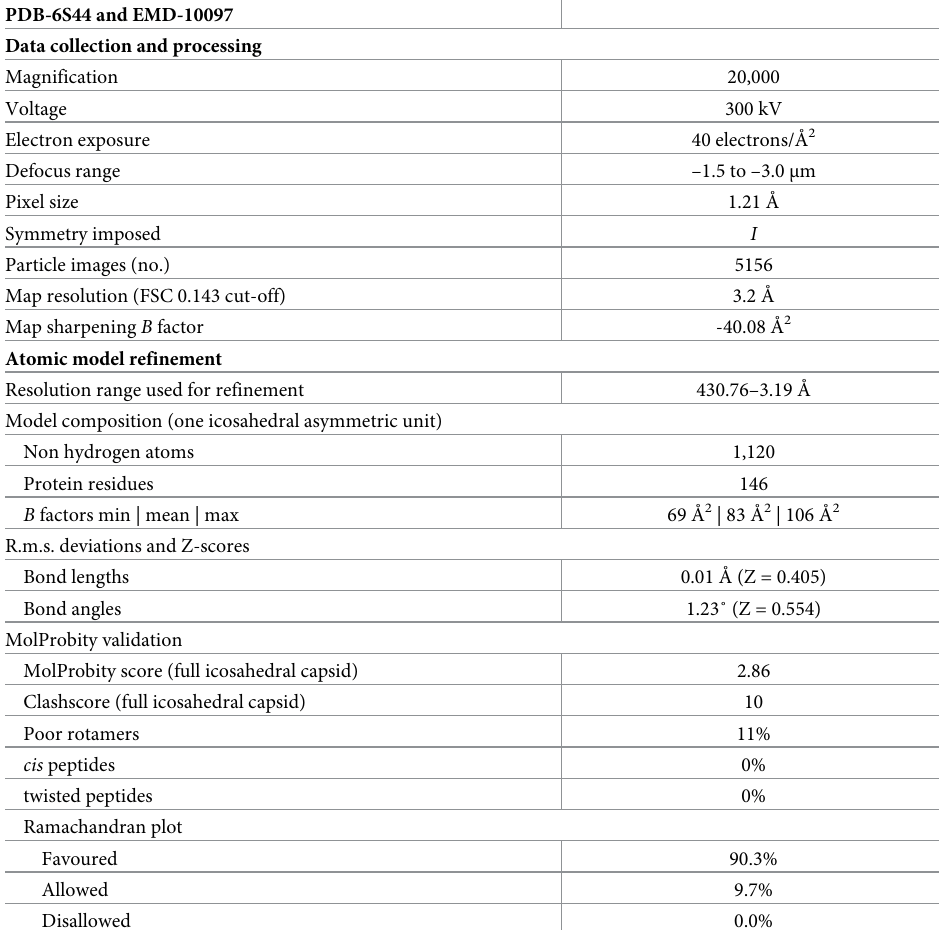
Table 1. Cryo-EM data collection, refinement, and validation